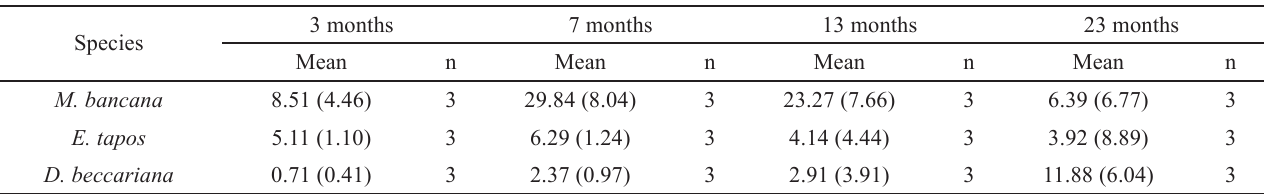
Table S2. Mean contribution of termites (± SD; %) for M. bancana , E. tapos , and D. beccariana during the 23 months. Contribution of termites = Differences in mass remaining between treatments. n = the number